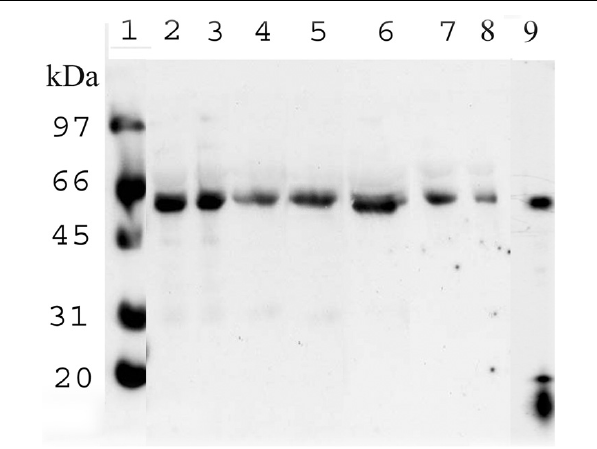
FIGURE 7 | Immunoblot ofA β in CSF after treatments to dissociate the A β –ERp57 complex. Channel 1 – molecular weight markers; channel 2 – untreated CSF; channel 3 – CSF treated with 70% formic acid; channel 4 – CSF treated with 80% trifluoroacetic acid; channel 5 – CSF treated with 6 M guanidine isothiocyante; channel 6 – CSF treated with 6 M urea; channel 7 – CSF proteins which did not bind to a boronate column; channel 8 – CSF proteins which bound to a boronate column; channel 9 – treatment of the complex with glycine buffer, pH 9.0 (taken from Erickson etal., 2005).